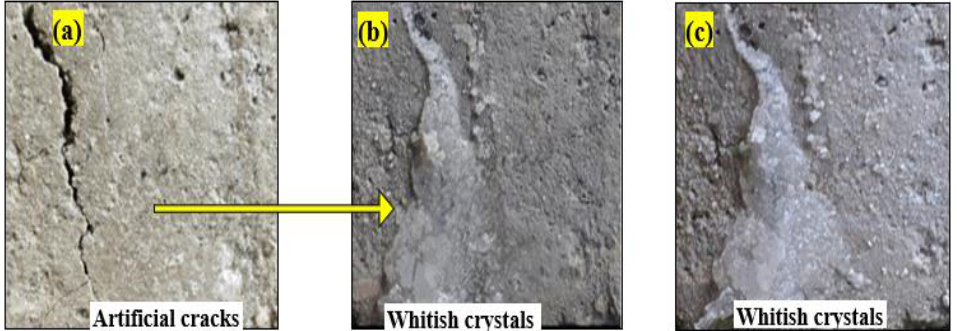
Figure 6. Self-Healing Mortars (SHM) containing bacteria concentration of 10 − 7 cell/mL: ( a ) before